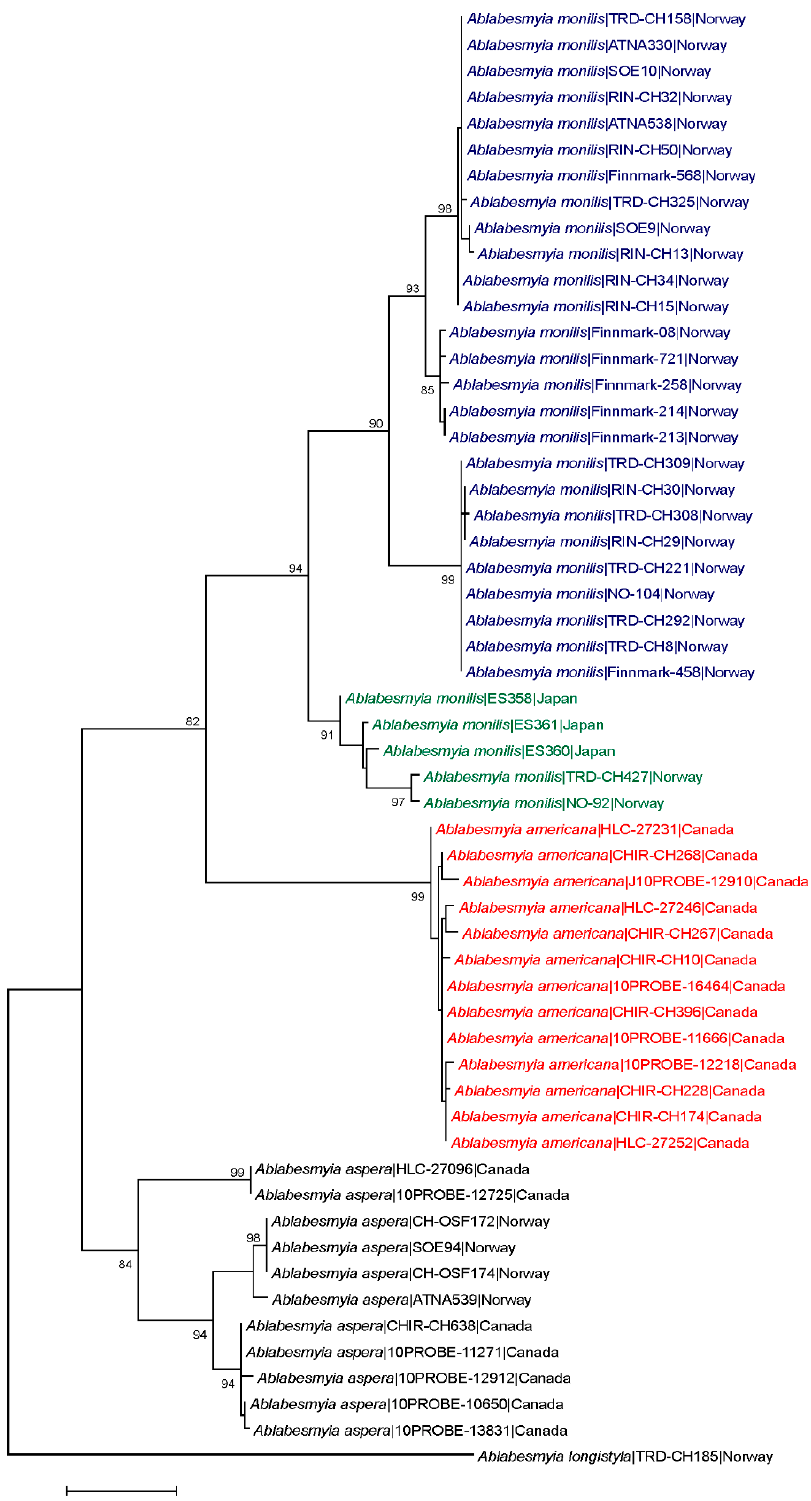
Figure 1. Maximum likelihood (ML) tree for species of Ablabesmyia , based on partial COI sequences (DNA barcodes) and using the Tamura 3-parameter model with gamma correction for rate heterogeneity. Numbers on branches are bootstrap values > 80%.